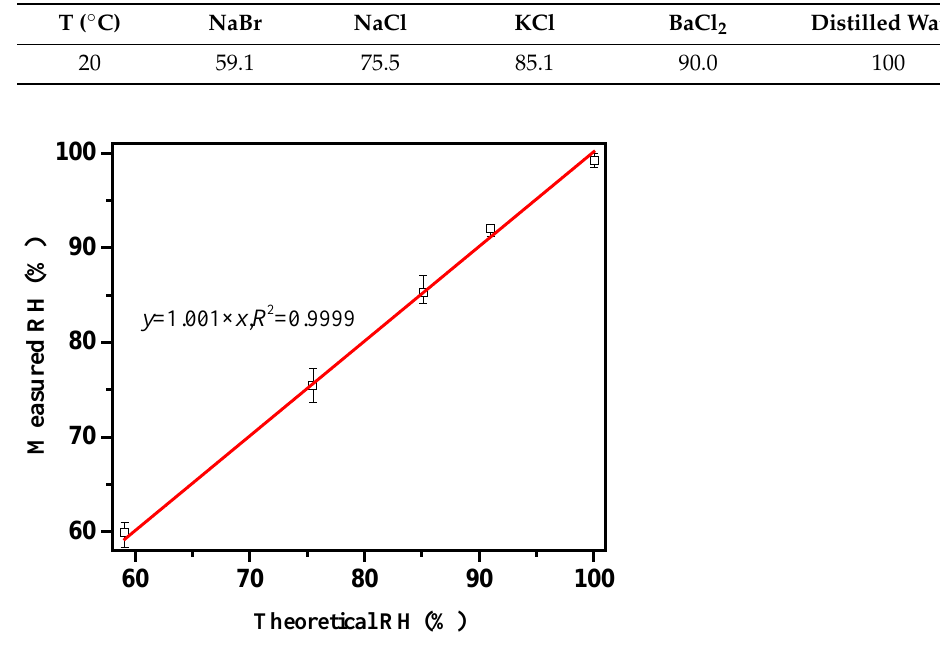
Figure 3. Temperature and humidity sensor calibration curve.